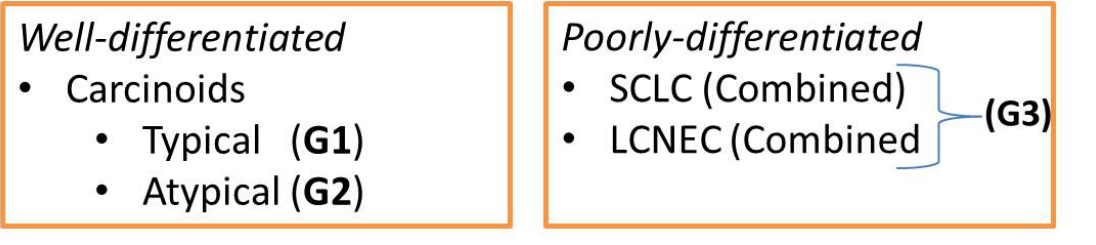
Figure 4. Well- and poorly-differentiated neuroendocrine tumors.